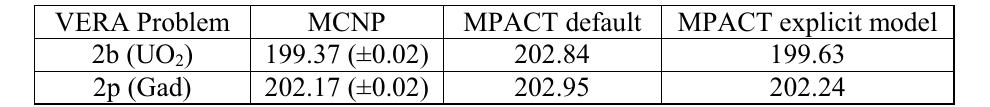
Table II. Comparison of overall effective kappa*